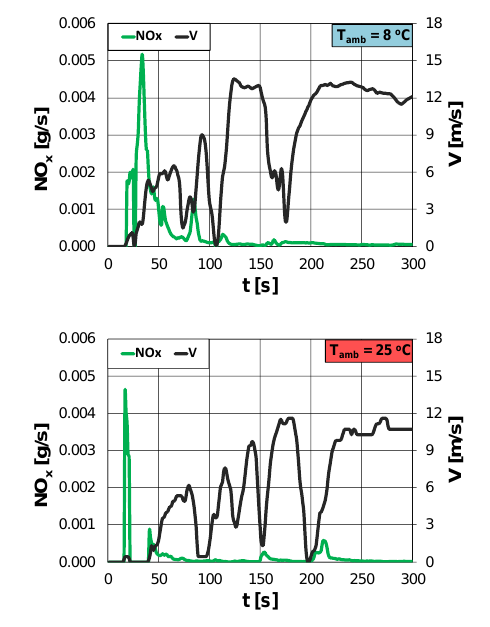
Fig. 9. Emission intensity of nitrogen oxides and vehicle speed during cold start at ambient temperature of 8ºC (a) and 25ºC (b)